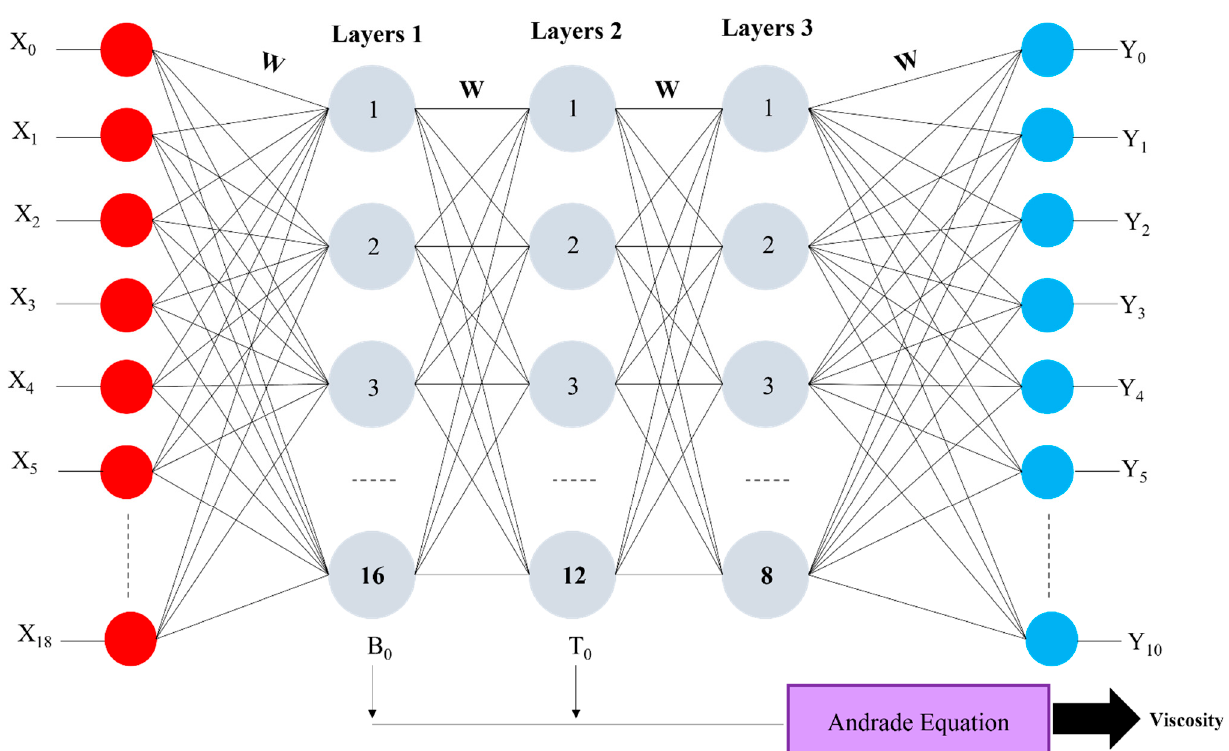
Figure 3. Visualization of the deep neural network model and training to predict B 0 and T 0 , which were used to calculate the Andrade equation.